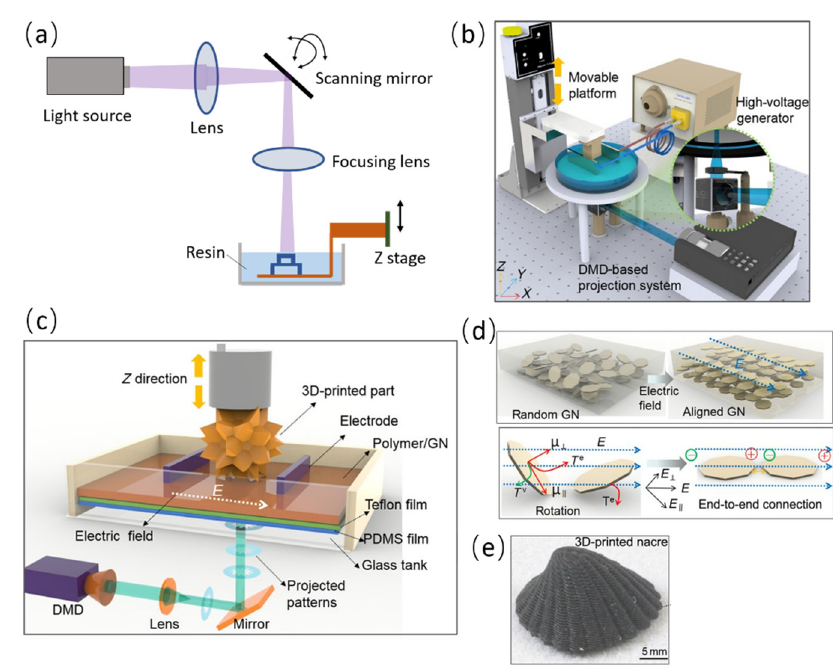
Figure 8. ( a ) The typical scanning–projection stereolithography system. ( b ) The setup of an electrically assisted stereolithography system. ( c ) Illustration of the bottom-up projection stereolithography with an electrical field. ( d ) The alignment of graphene nanoplatelets under the electric field and alignment mechanisms. ( e ) Electrically assisted 3D-printed nacre with graphene nanoplatelets [118].